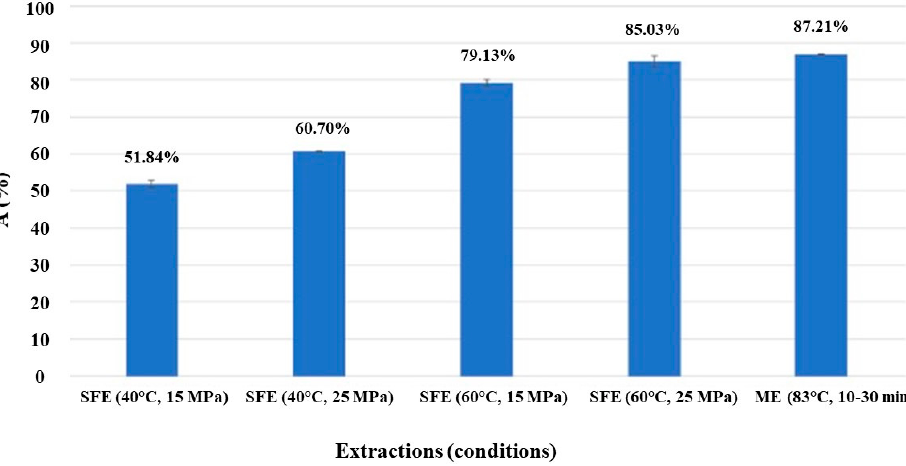
Figure 4. Results for the antioxidant activity of extracts obtained under different pressures and temperatures (SFE = supercritical fluid extraction and ME = maceration extraction).